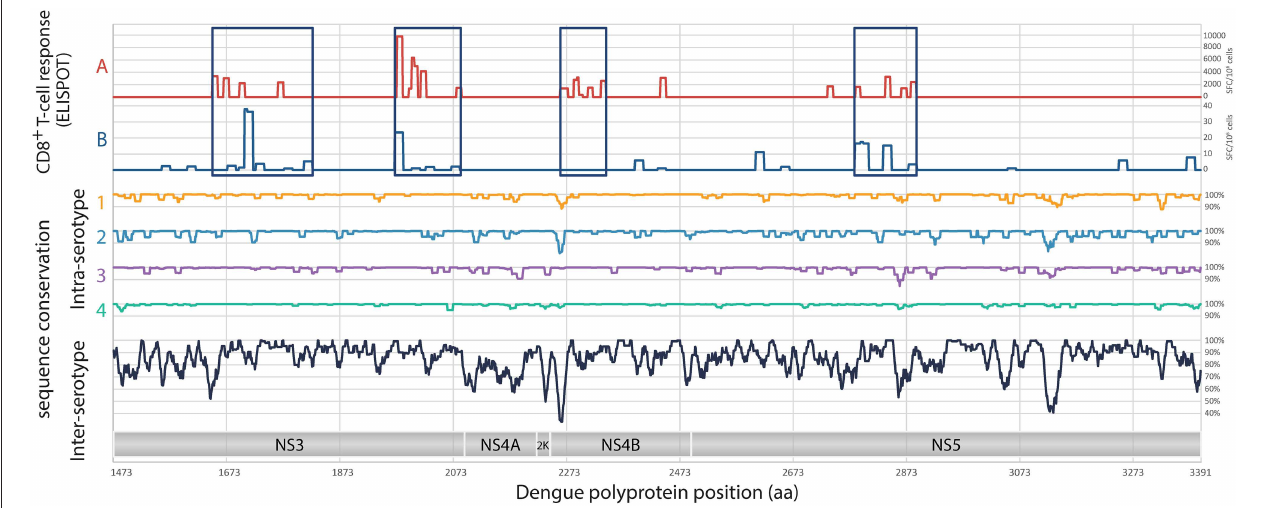
FIGURE 1 | Analysis of target regions for T cells and sequence conservation of non-structural proteins of DENV. Analyses of the magnitude of T cell responses, in SFC/10 6 cells (A) , from Weiskopf et al. (24), and in SFC/10 6 cells (B) , from Rivino et al. (28). Intra-serotypes and inter-serotypes sequence conservation are represented for DENV1 (yellow line), DENV2 (blue line), DENV3 (purple line), DENV4 (green line), and for all DENV serotypes (black lines),